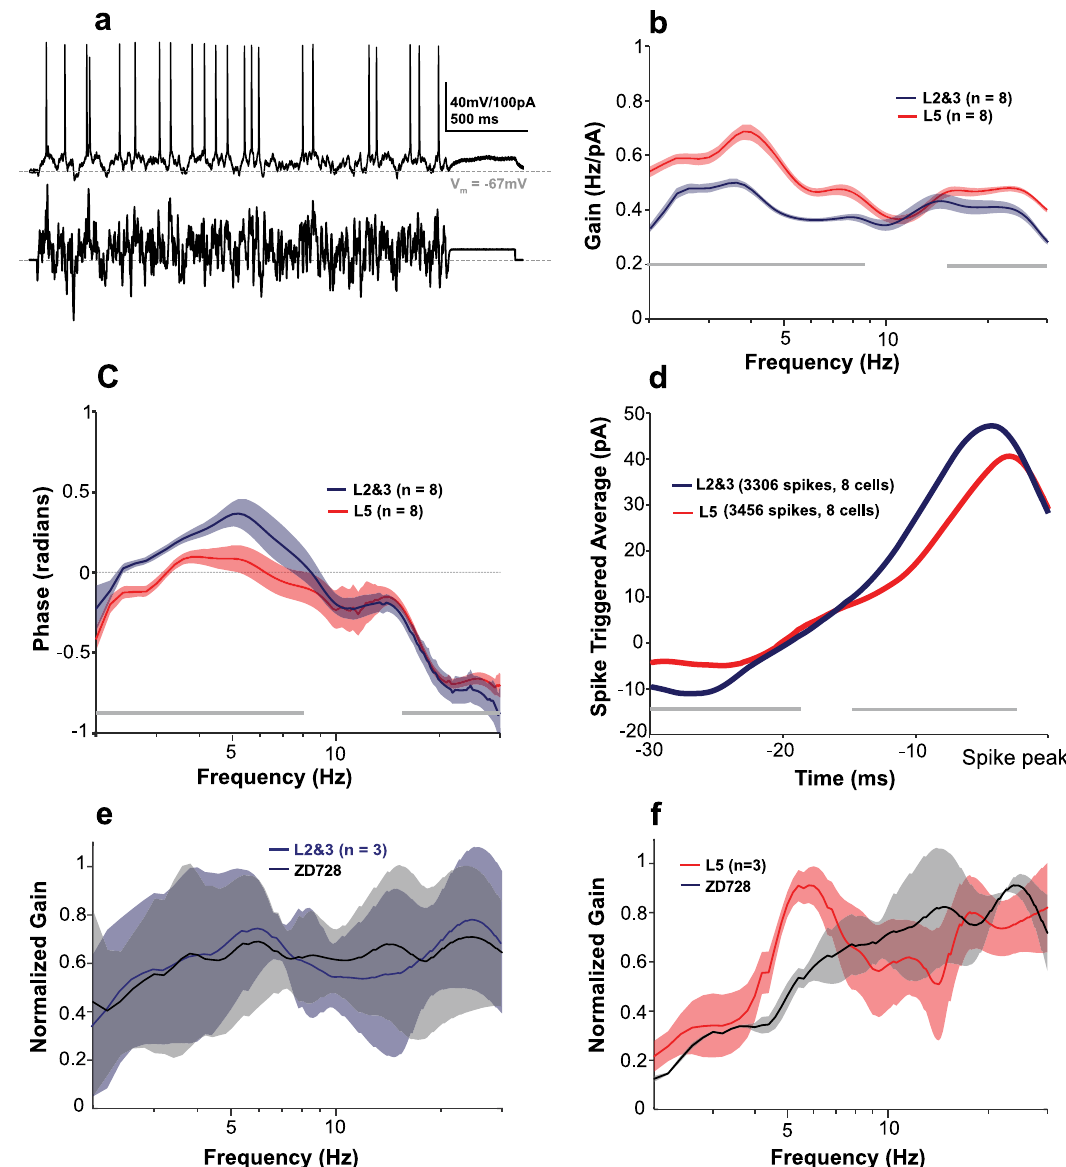
pyramidal cells show positive phase in their mean phase shift pro fi le, which represents a lag in L2&3 pyramidal cells compared to L5 pyramidal cells ( p < 0.05; Mann – Whitney U ). d Mean spike-triggered average (STAs) for L5 and L2&3 neurons. Difference in STAs indicate that L5 neurons require less current and instantaneous rate of current increase to initiate a spike (greater excitability). e , f Frequency-dependent gain pro fi le (mean ± one standard deviation) of L2&3 ( n = 3; RMP: − 66.2 ± 2.9 mV, input resistance: 105 ± 26.46 M Ω ) ( e ) and L5 ( n = 3; RMP: − 66.8 ± 3.1 mV, input resistance: 81.3 ± 12 M Ω ) ( f ) pyramidal cells before and after I h blocker (ZD7288 10 µ M). ZD7288 abolished the low-frequency peaks in L5 neurons with little change in frequency-dependent gain in L2&3 neurons. Source data are provided as a Source data fi